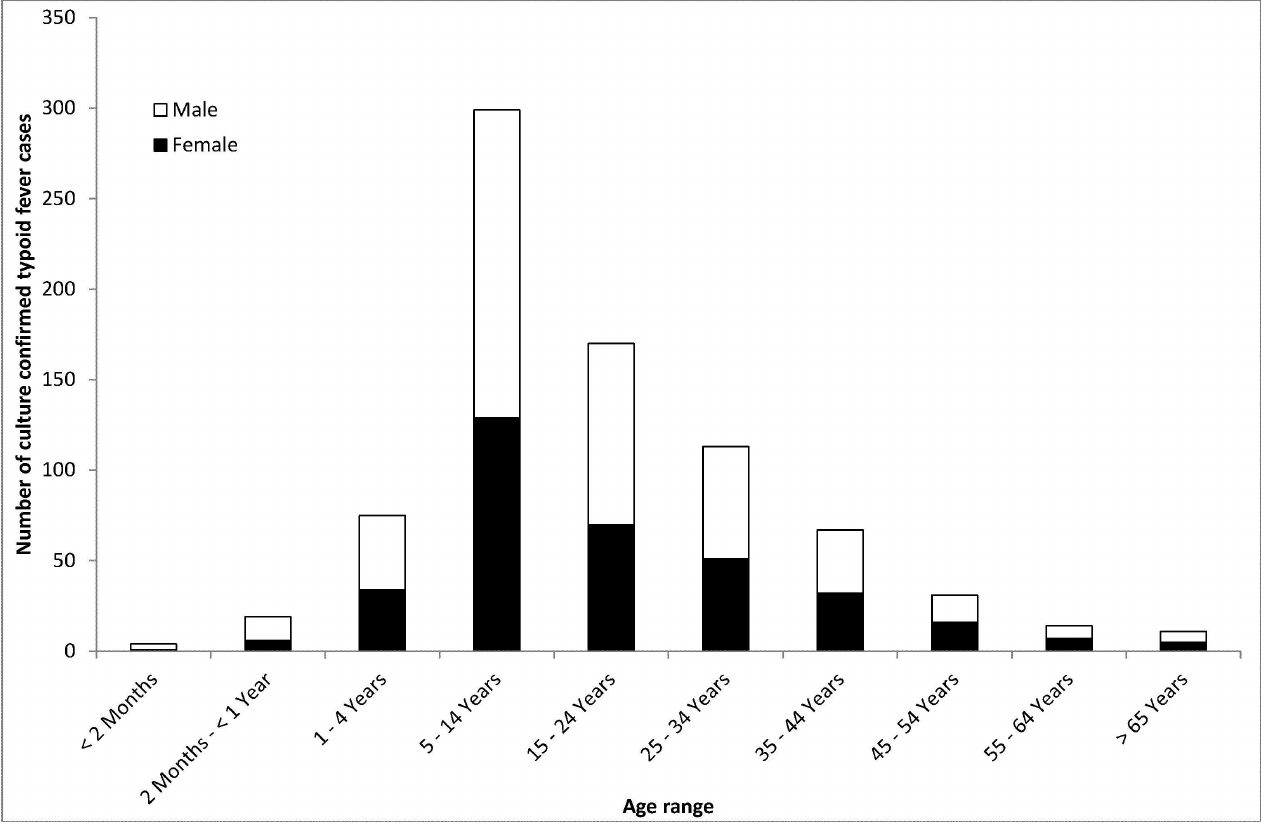
Fig 1. Number of culture-confirmed typhoid fever cases (N = 803) by age range and sex in South Africa,